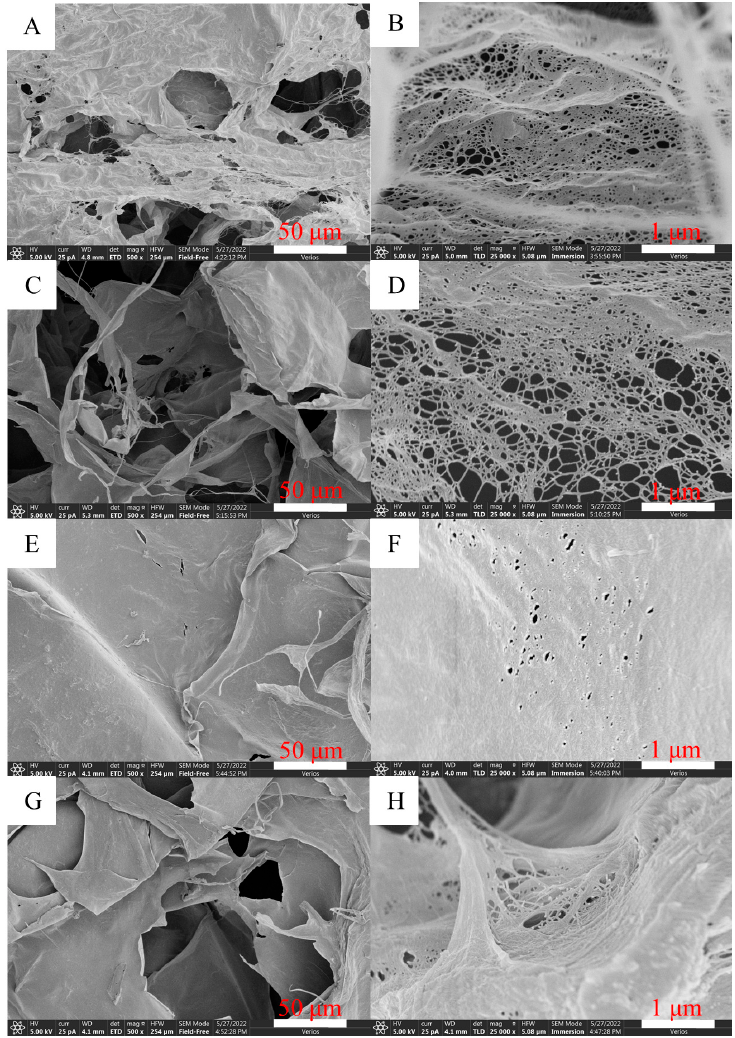
Figure 5. SEM images of CNF aerogels (( A , B ) CNFA0.25; ( C , D ) CNFA0.5; ( E , F ) CNFA0.75; ( G , H )